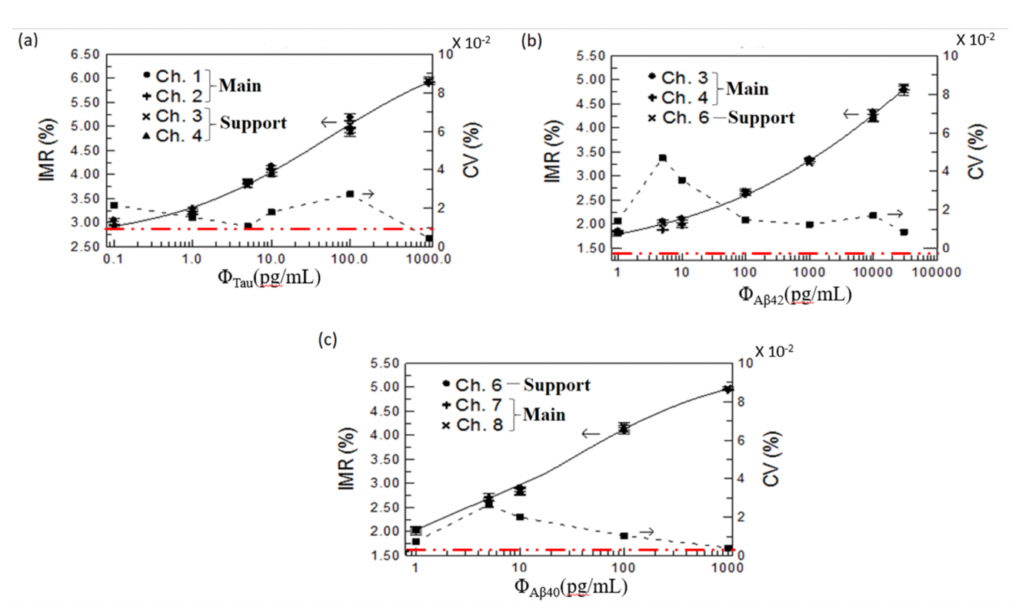
Figure 5. Relationship between the concentrations of ( a ) A β 40; ( b ) A β 42; and ( c ) tau protein and the measurement parameters of IMR and CV values in and among channels. IMR with a low detection limit for the various biomarkers is marked with red doted